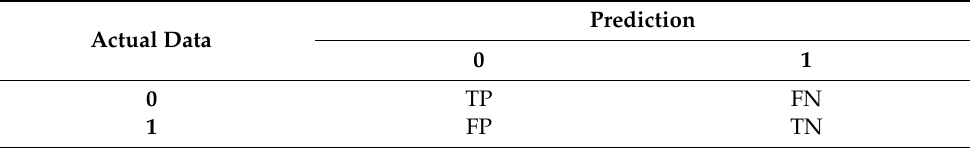
Table 2. Confusion matrix.